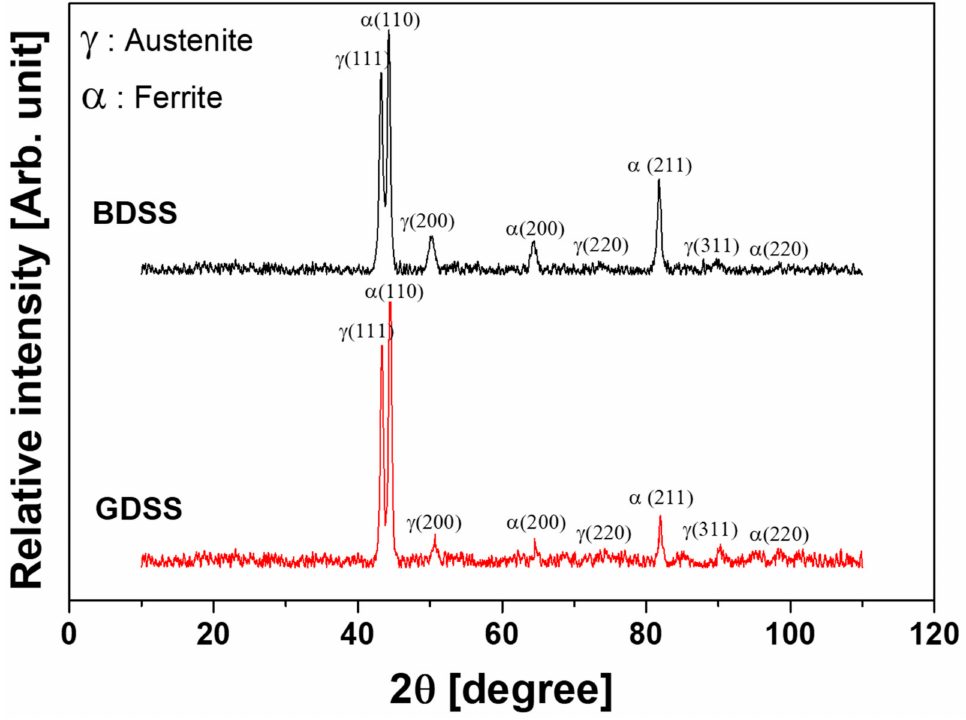
Figure 3. X-ray diffraction patterns of BDSS and